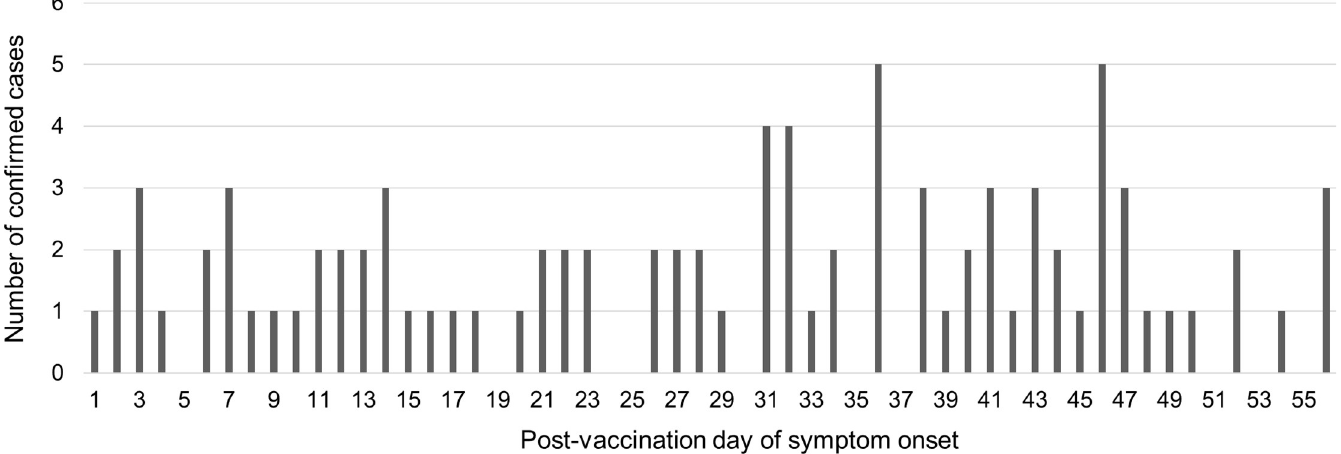
Fig 2. Temporal distribution of adjudicated Kawasaki disease symptom onsets for the 91 confirmed cases during Days 1–56 post–PCV13 vaccination for which the difference between the hospital admission date and adjudicated symptom onset date was � 14 days. PVC13, 13-valent pneumococcal conjugate vaccine.